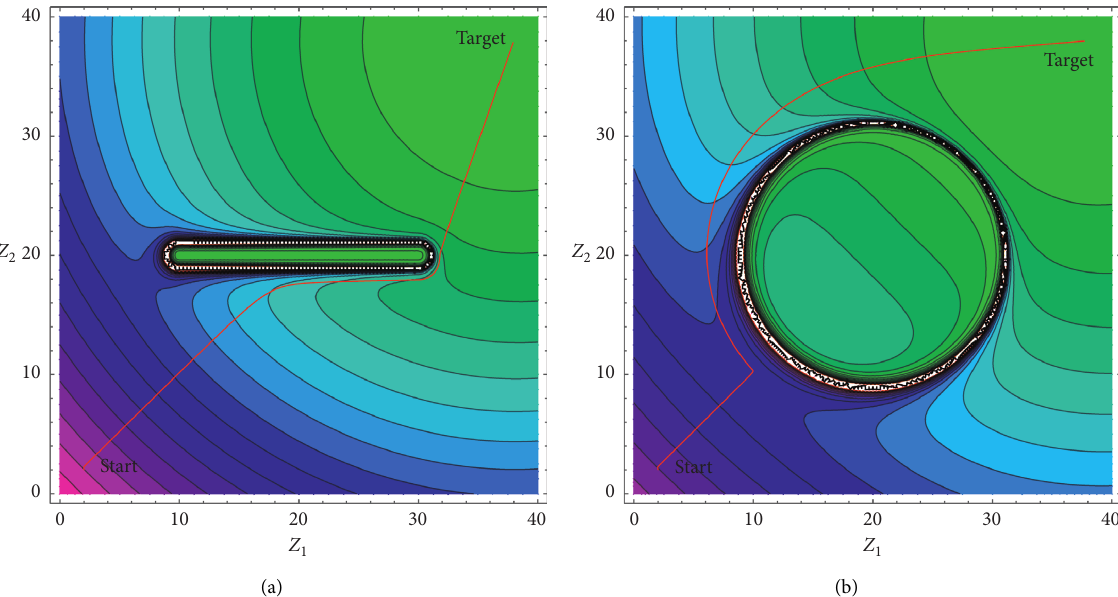
Figure 5: The contour plots of the total potential fields generated in the presence of a rod-shaped and a disk-shaped obstacle. (a) Rod-shaped obstacle. (b) Disk-shaped obstacle.